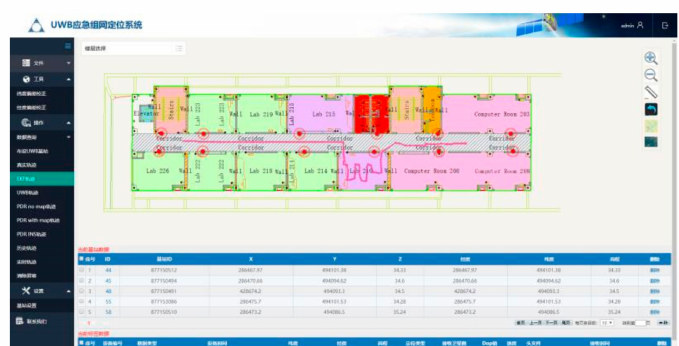
Figure 2. Personnel monitoring and dispatching system.